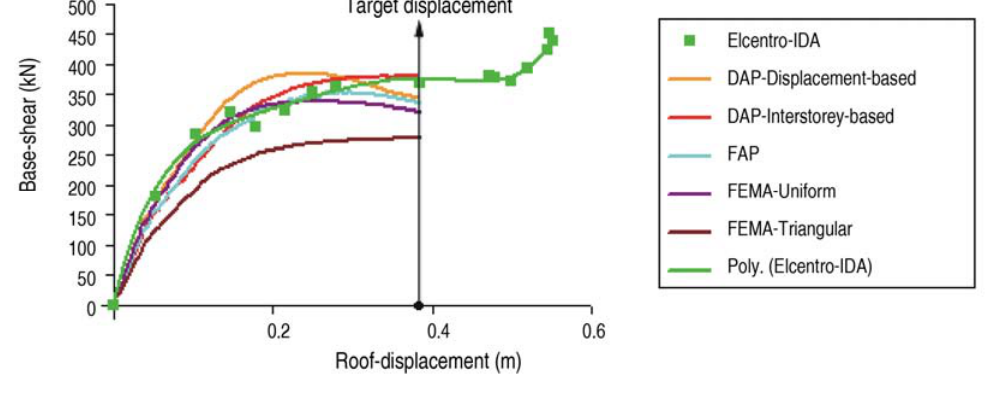
Fig. 8. Static capacity curves vs. dynamic capacity curve